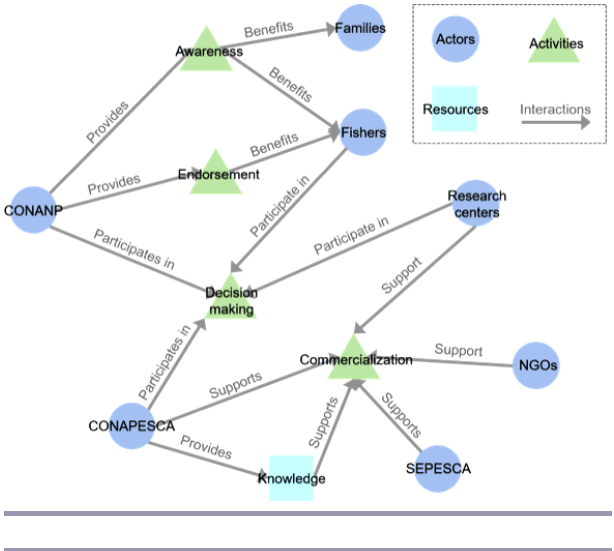
Fig. 5 . Individual mental model of the representative of a research center.